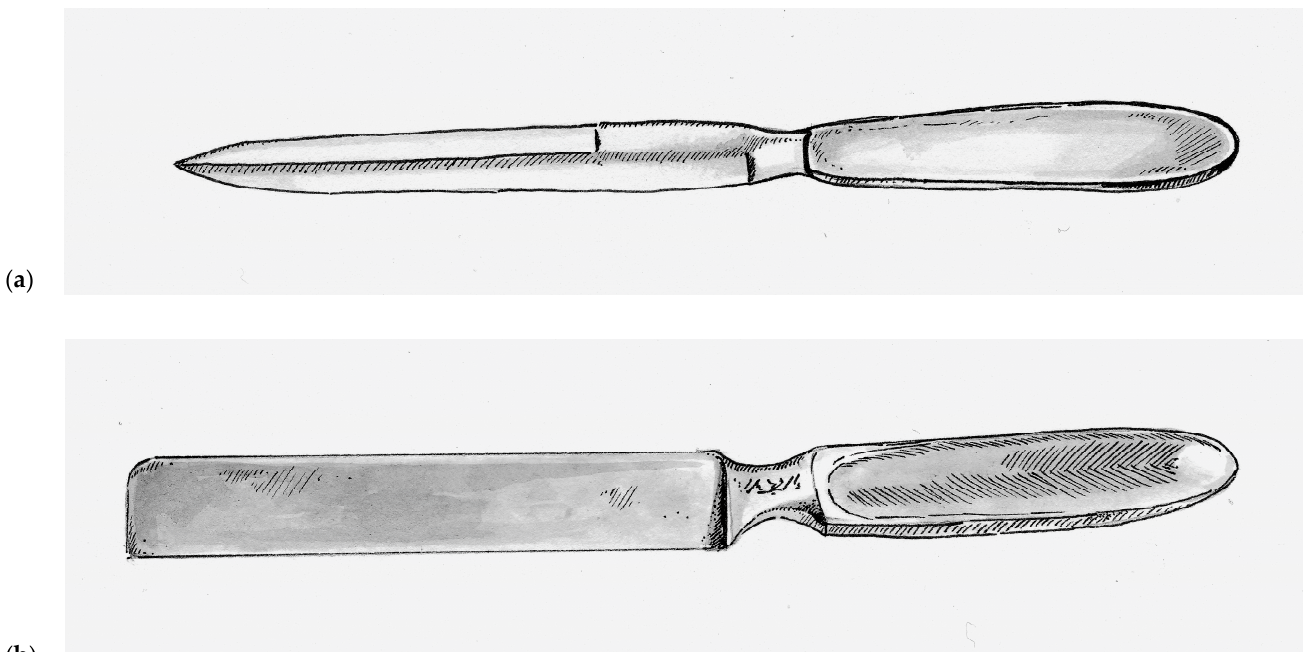
Figure 1. Early skin grafting knives: ( a ) The Catlin knife from the 19th century and earlier; ( b ) Thiersch’s knife in 1920.